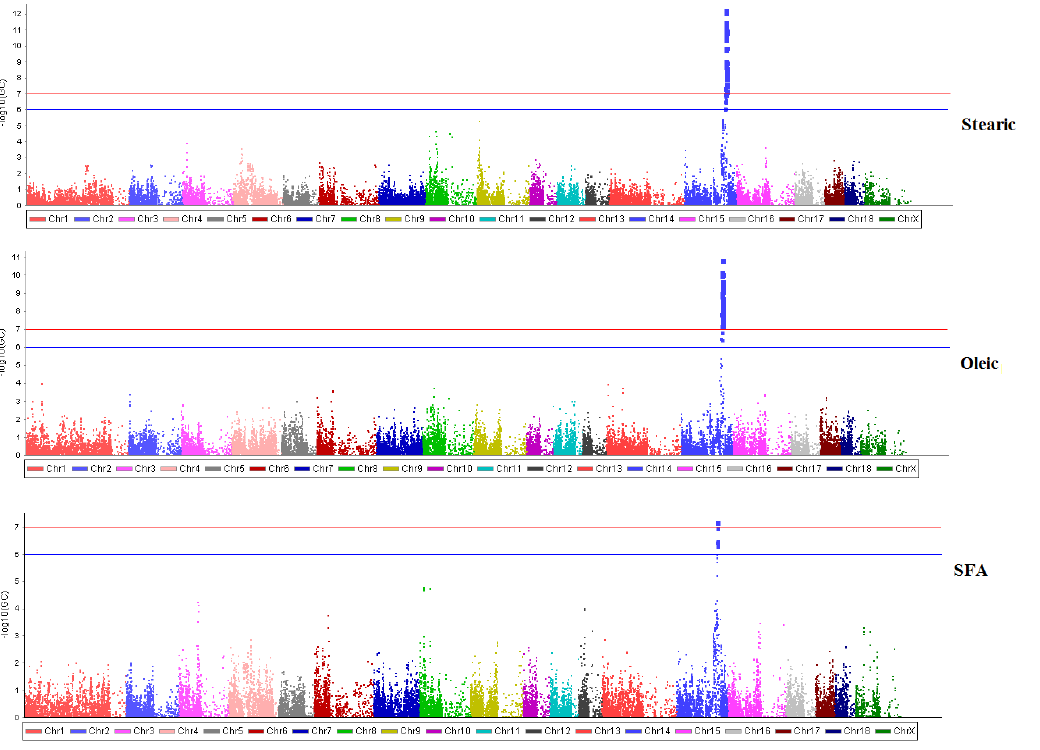
Figure 2. Manhattan plots of genome wide association study (GWAS) for stearic (A), oleic (B) and saturated fatty acid (SFA) (C). Chromosomes are represented on the X-axis while p-values are on the Y-axis. Bonferroni threshold p-values at 5% and 1% are indicated by the blue and red horizontal lines, respectively.